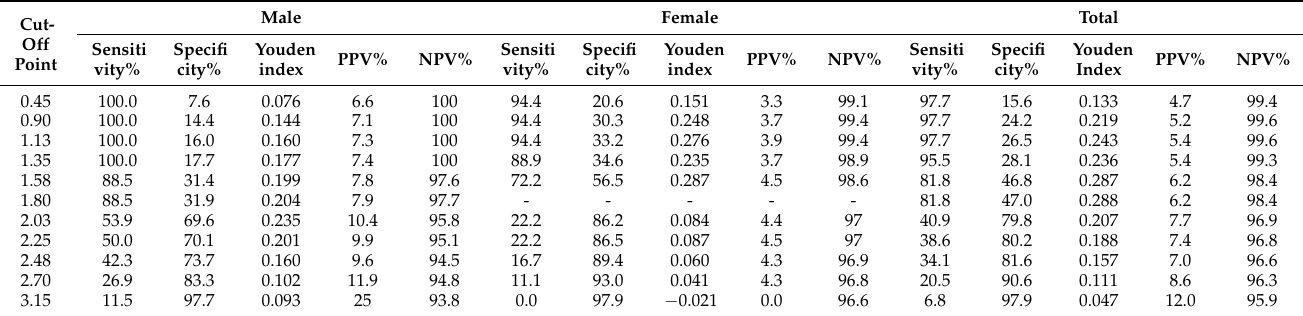
Table 7. Sensitivity, specificity, Youden index, positive predictive value (PPV), and negative predictive value (NPV) of the model cut-off points in identifying cerebrovascular disease in men and women in this study. Male Female 88.5 Cut-Off Sensitiv- Specific- Youden Sensitiv- Specific- Youden Sensitiv- Specific- Youden Point PPV% NPV% PPV% NPV% PPV% NPV% ity% ity% index ity% ity% Index ity% ity% index